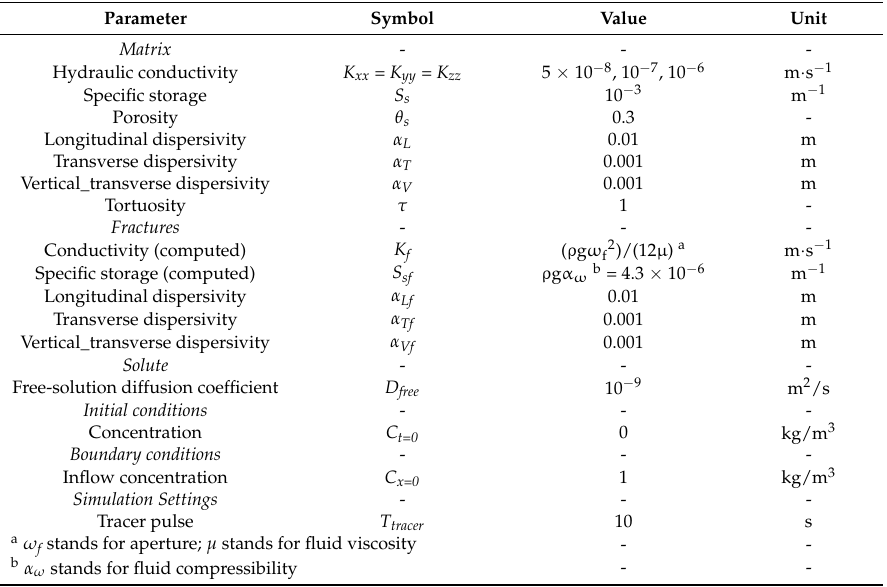
Table 1. Model parameters and initial and boundary conditions used in the simulations.